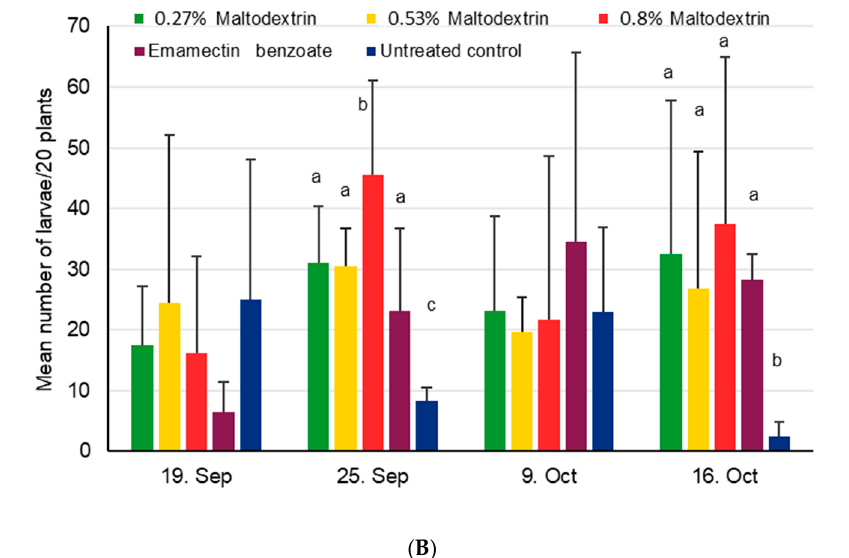
Figure 1. Mean number of fall armyworm (FAW) larvae + SD found on 20 maize plants in the maltodextrin trial during vegetative growing stages conducted in 2018. Within a given date, bars sharing the same letters are not significantly di ff erent from each other. If no letters are shown this indicates that no di ff erences were found. ( A ) Site 1 near Wa, Upper West, Ghana, where treatments were applied on 16 August, 6 September, and 27 September. ( B ) Site 2 near Accra, Ghana, where treatments were applied on 20 September and 10 October.